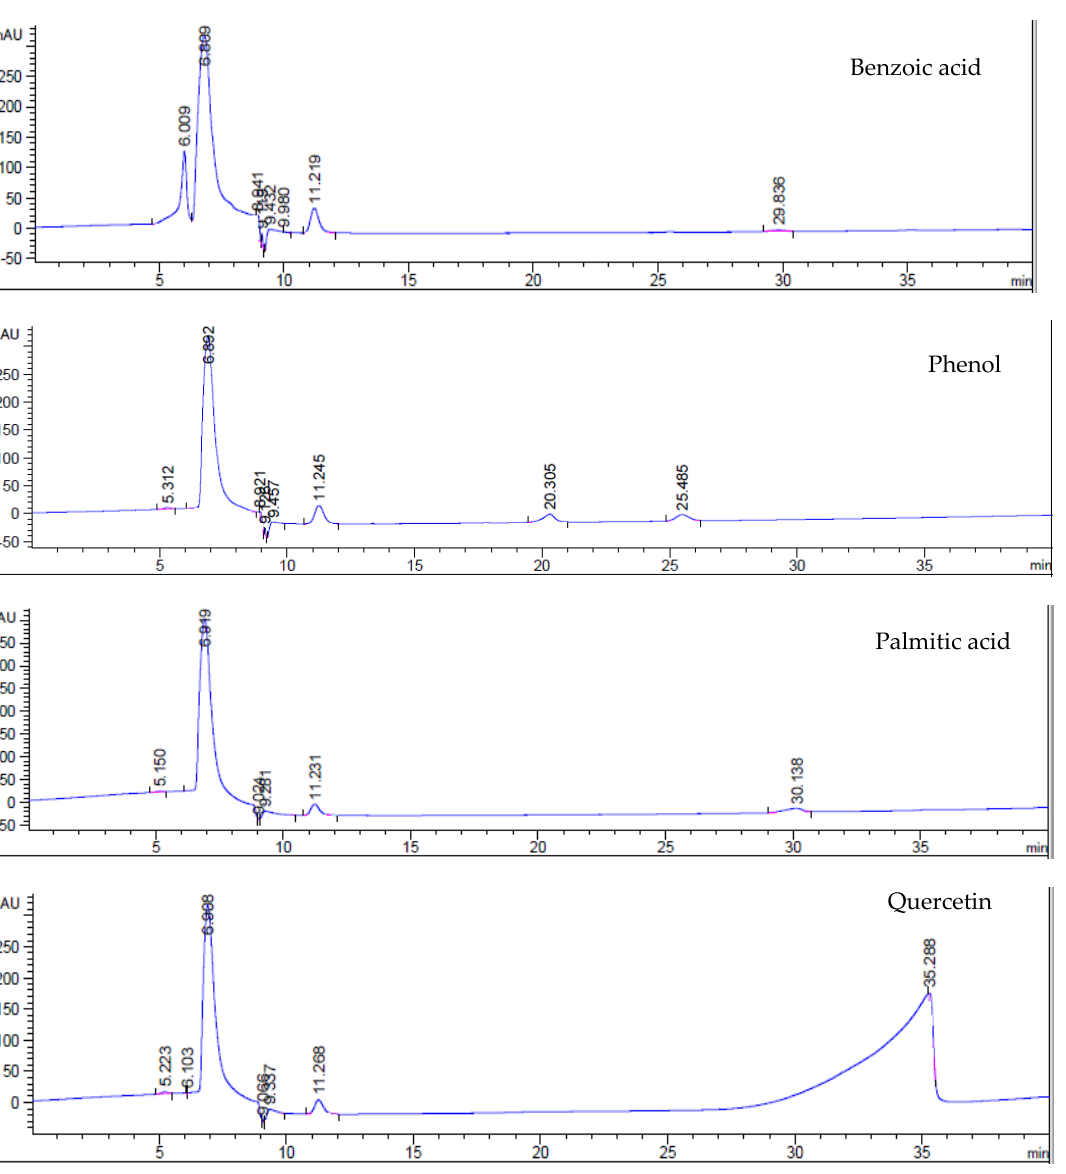
Figure 7. HPLC chromatogram of standards (phenol, benzoic acid, palmitic acid) and P. macrocarpa extracts. The extraction used methanol as the extraction solvent.